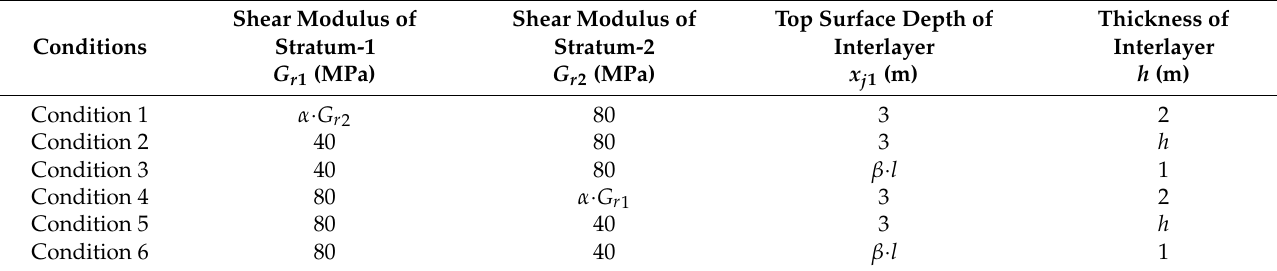
Table 2. Several special conditions in Case 2.